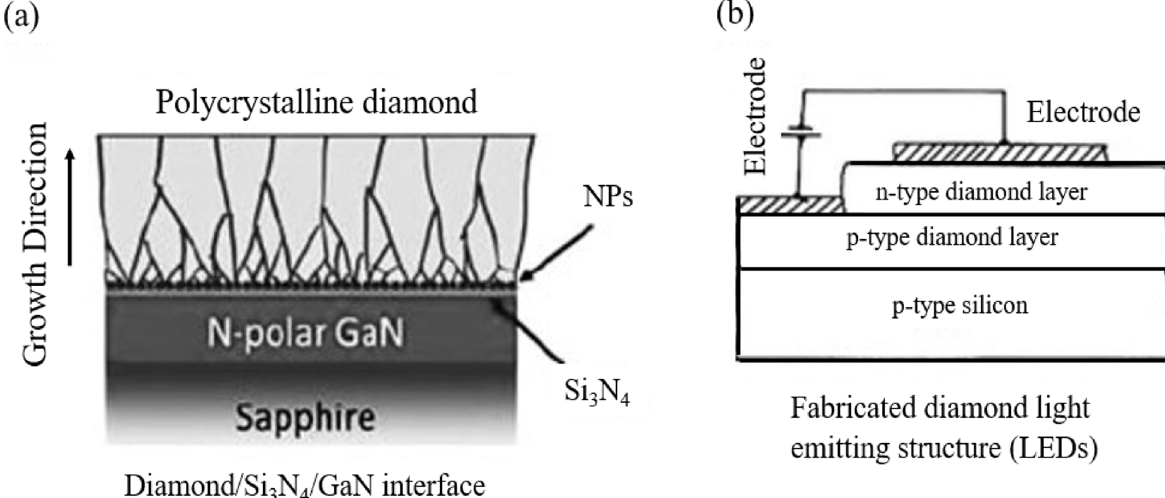
Fig. 2 The role of carbon-based materials (CM) shows for either active or passive devices: a diamond growth on Si 3 N 4 [21], and b the diamond diode structure. Reproduced with permission [22]. Copyright 2003, Elsevier